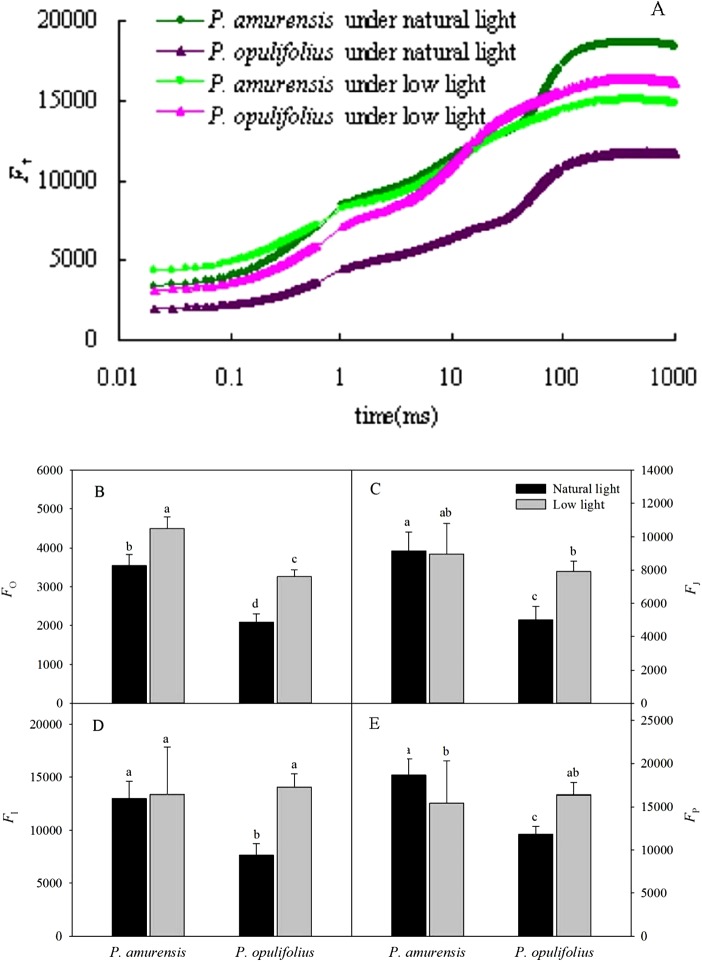
(A) is Chlorophyll α fluorescence transients in leaves of two cultivars of Physocarpus under different light intensities.P. amurensis in natural light is depicted in dark green, and low light in light green. P. opulifolius is depicted in dark purple triangles for natural light, and light purple triangles for low light conditions. Fo (B), FJ (C), FI (D) and Fm (E) in leaves of two cultivars of Physocarpus under different light intensities. Bar graphs depict mean and SE, values followed by different small letters mean significant difference (p < 0.05).